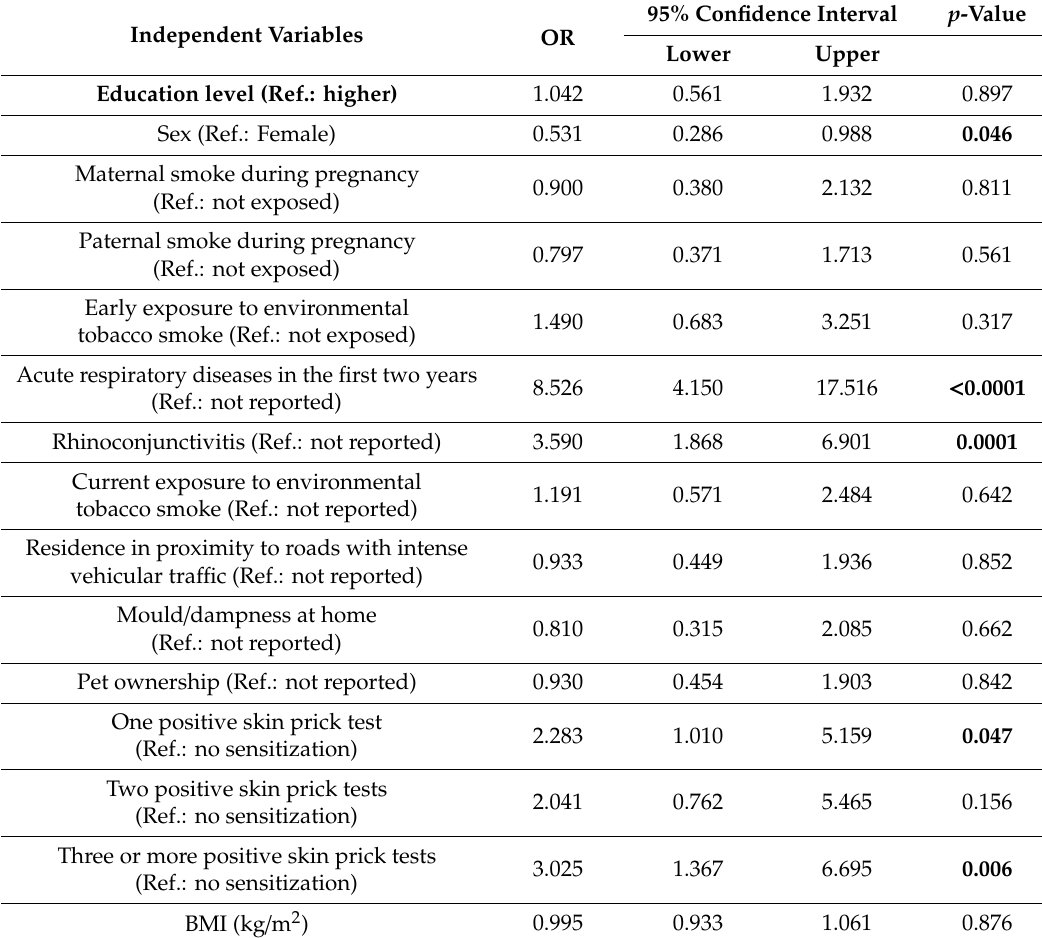
Table 6. Multiple logistic association model for current asthma in the overall study population ( n = 1714). OR: Odds Ratio. Significant p -Values are in bold.